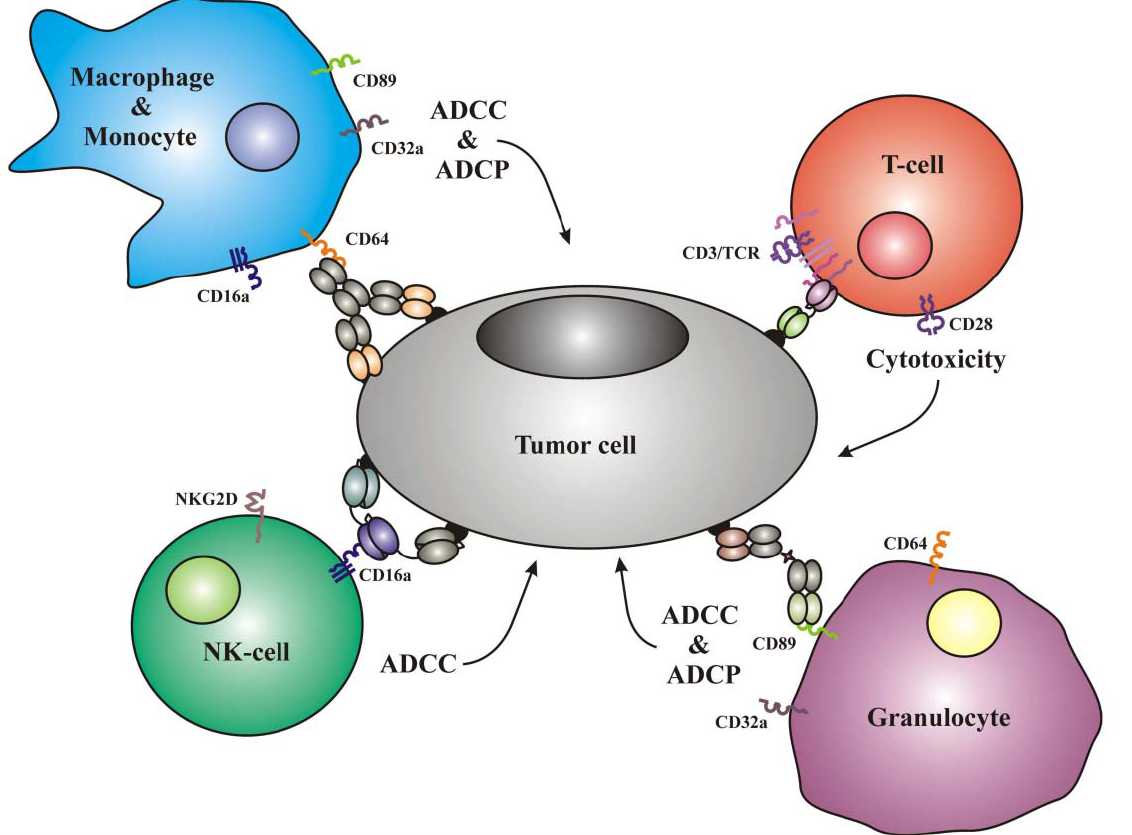
Figure 1. Elimination of tumor cells decorated with an ab-derived therapeutic protein via the recruitment of effector cells. Depending on the type of effector cell and the chosen trigger molecule, the mode of action can be either antibody dependent cellular cytotoxicity (ADCC), antibody dependent cellular phagocytosis (ADCP), or a cytotoxic T-cell reaction. The depicted cytotoxic agents are a monoclonal ab, a bispecific chemically coupled F(ab) a recombinant bispecific tandem single-chain Fv-fragment (bsscFv), and a trispecific tandem single chain triplebody